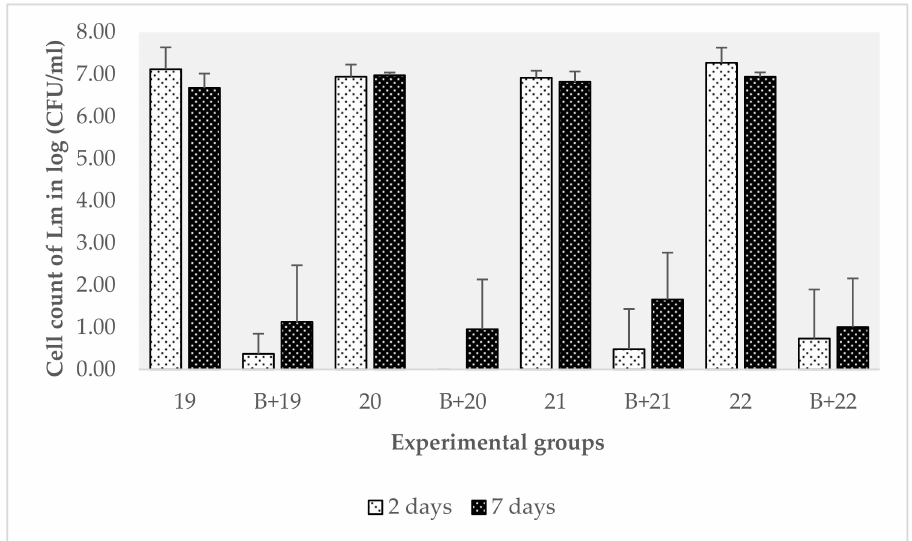
Figure 4. Counts on ALOA agar of Listeria monocytogenes strains from the washing solutions of control biofilms (Lm 19, 20, 21, 22) and mixed biofilms with B. safensis at two and seven days of incubation. The error bars represent the standard error of the mean (n = 4). For the Lm 3 strain for which no two-day count was observed (B + 20), the mean count of L. monocytogenes was 0